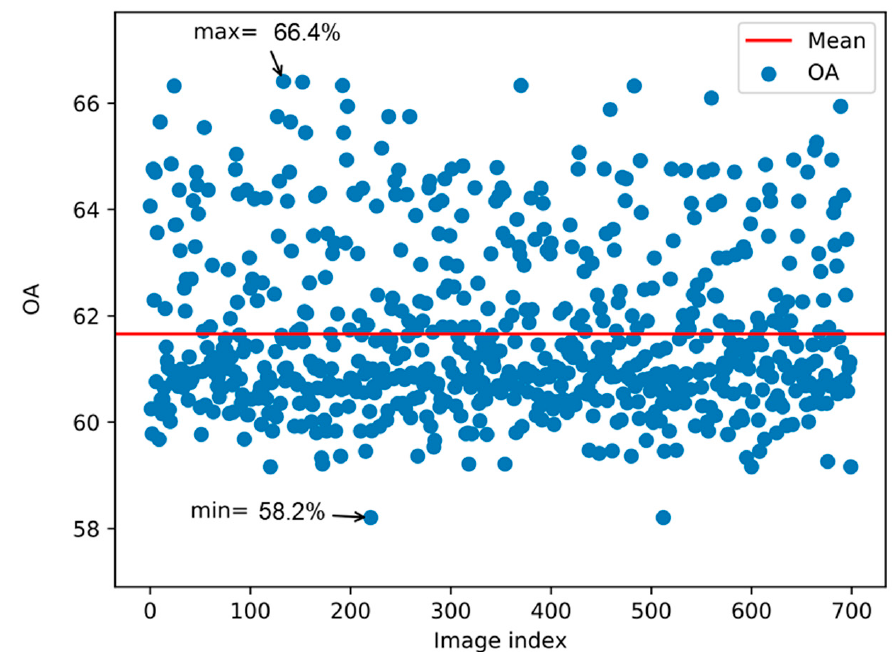
Figure 3. Classification OA when obtained single-angle images were utilized as the input data. The red line represents the average OA of every single-angle classification OA result.